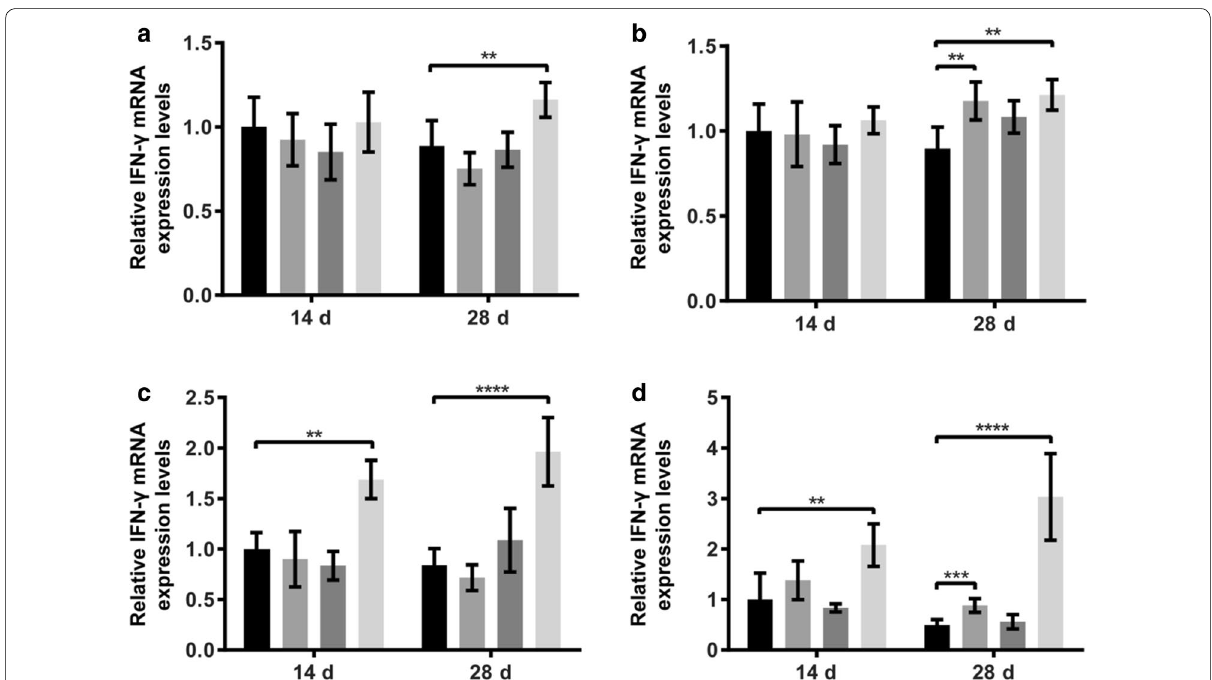
Fig. 1 Effects of different dietary supplements on the relative mRNA expression of IFN‑γ of laying hens. a Expression levels of IFN‑γ mRNA in the liver at different time points; b Expression levels of IFN‑γ mRNA in the spleen at different time points; c Expression levels of IFN‑γ mRNA in the ileum at different time points; d Expression levels of IFN‑γ mRNA in the cecum at different time